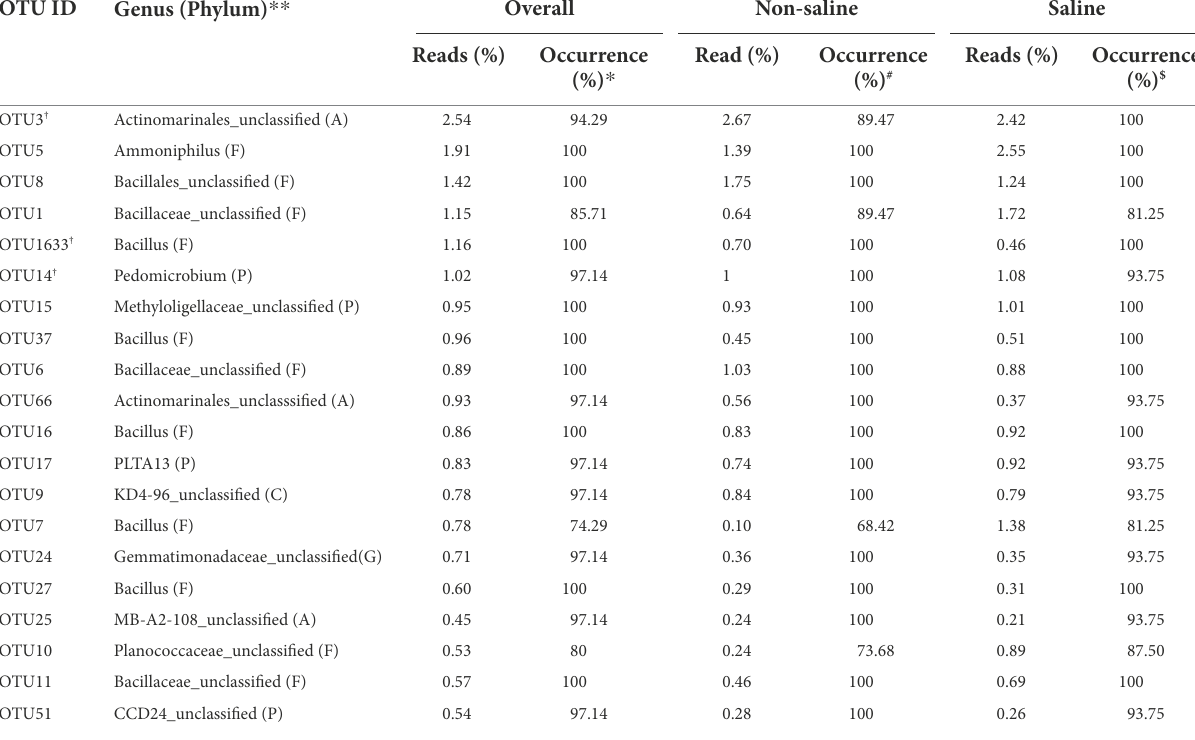
TABLE 1 Taxonomic affinity, read abundance, and occurrence of the 20 most abundant operational taxonomic units (OTUs) detected in soil under non-saline water and saline groundwater